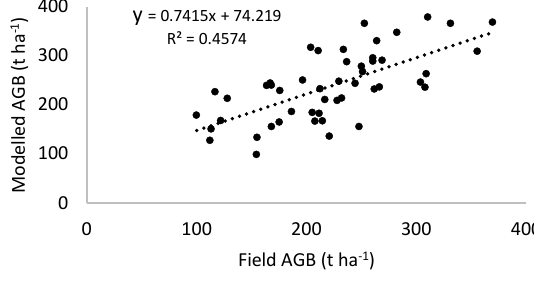
Figure 6: - Co-relation between field AGB (x axis) and modelled AGB (y axis) for 49 plots.